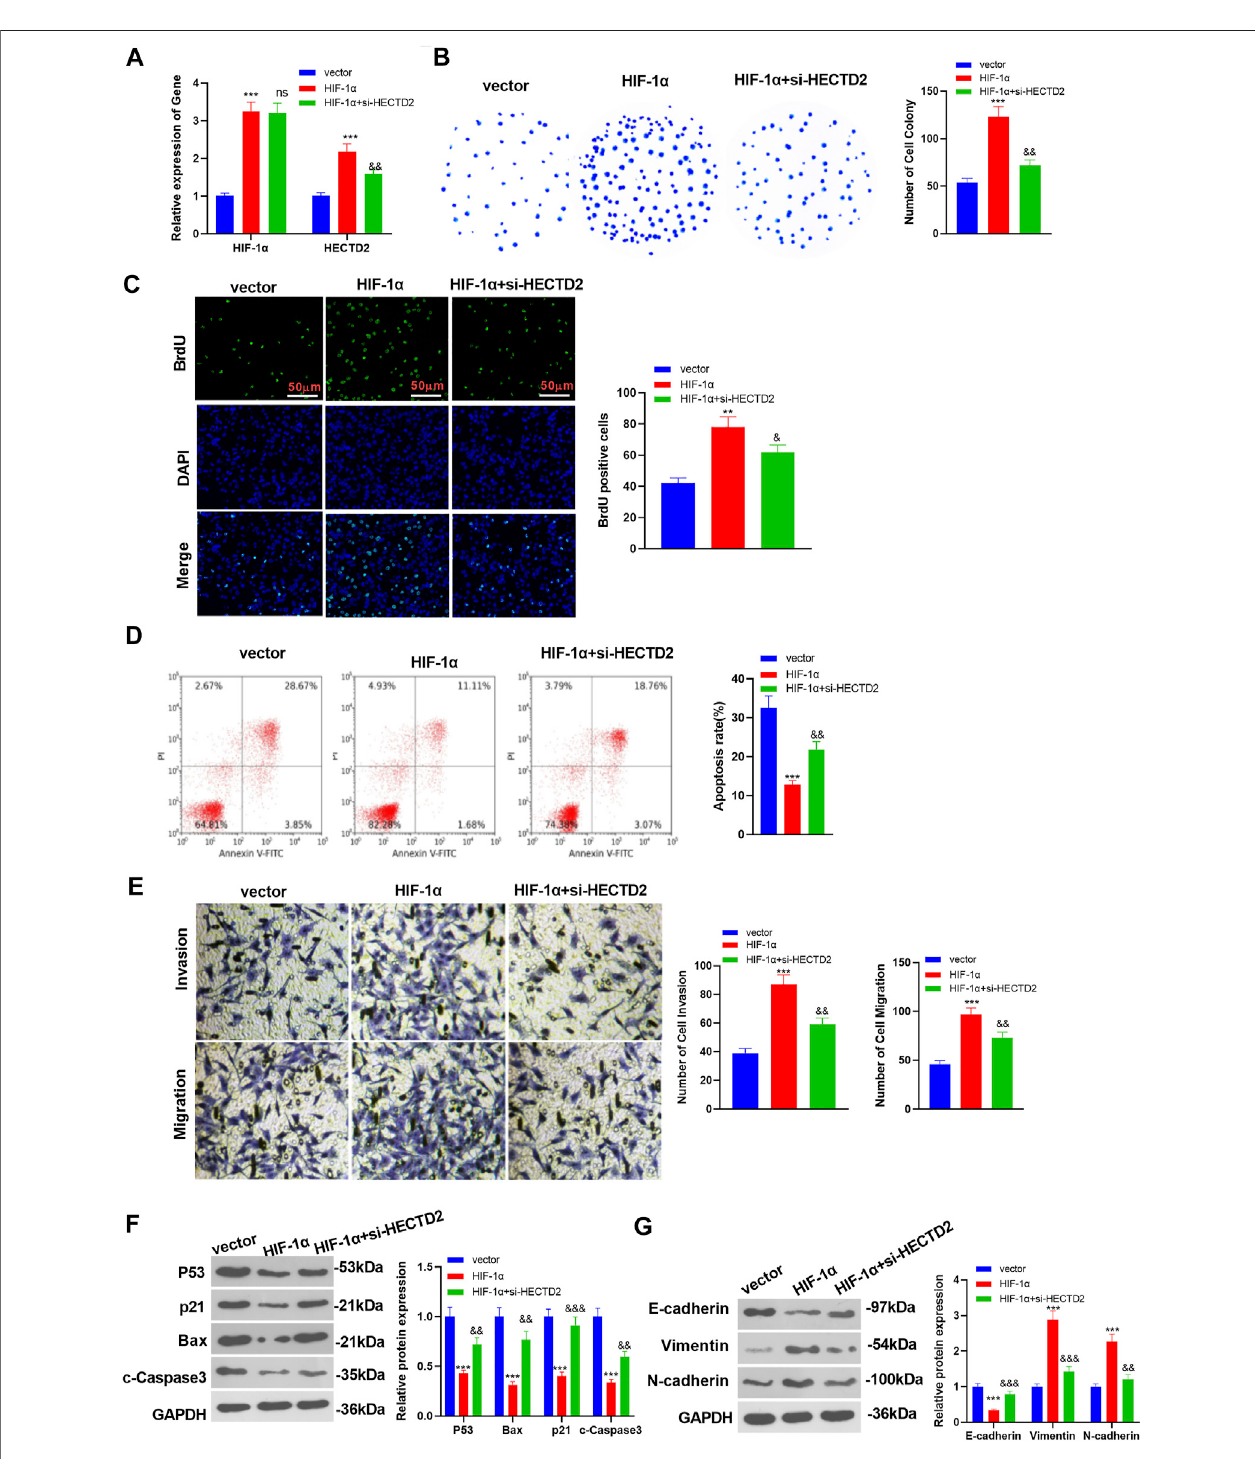
FIGURE 4 | HIF-1 α heightened the expression of HECTD2 and its malignant phenotype. HECTD2 was knocked down in 786-O cells overexpressing HIF-1 α . (A) : RT-qPCRwascarriedouttomonitorthelevelsofHIF-1 α andHECTD2. (B – D) :RCCcellproliferationandapoptosiswerecheckedusingthecolonyformationexperiment, BrdU assay and fl ow cytometry, respectively. (E) : Transwell assay wasconducted tomeasure RCC cell migration and invasion. (F,G) : The expression ofP53, Bax, p21, c-Caspase3,E-cadherin,Vimentin,andN-cadherinwascomparedbyWB.*** p < 0.001(vs.vectorgroup).ns p > 0.05,&& p < 0.01(vs.HIF-1 α group). N (cid:2) 3.Scale bar (cid:2) 50 μ m.